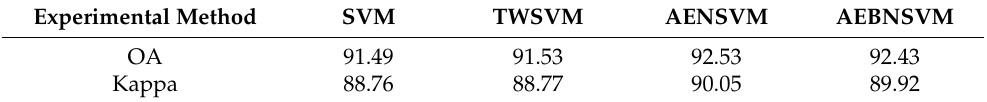
Figure 10. Classification results of different categories of Pavia University hyperspectral images. Table 6. Classification results of Pavia University hyperspectral